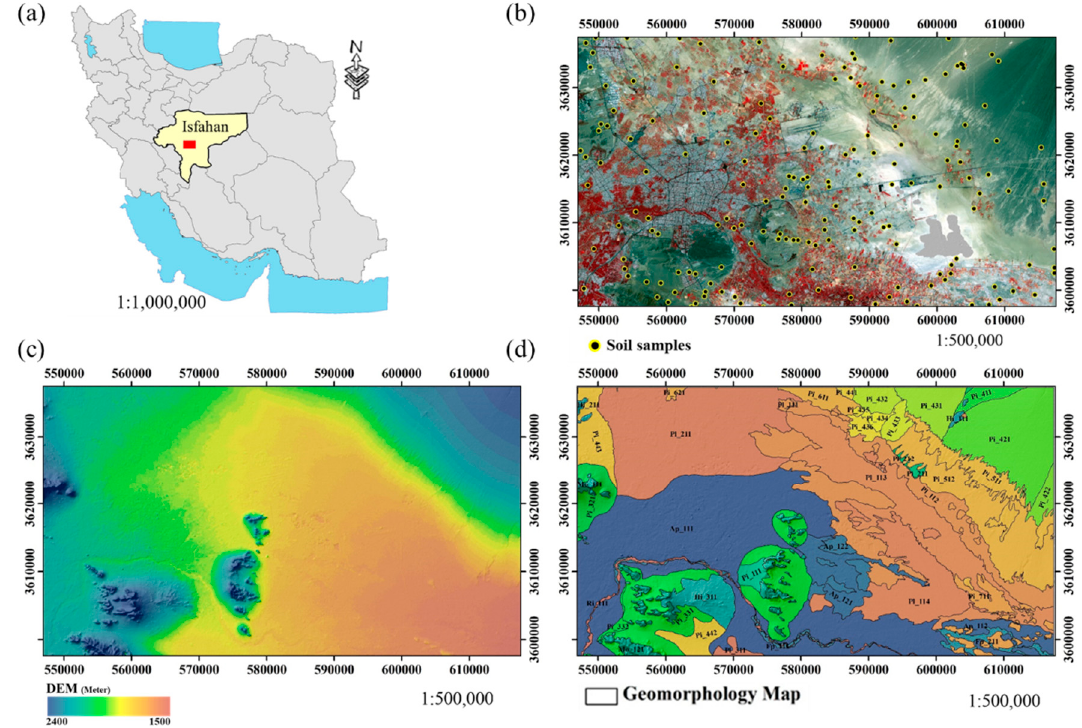
Figure 1. Location of study area in Iran ( a ); soil samples distribution ( b ); a digital elevation model ( c ) and geomorphology map of the region ( d ). Codes of geomorphology map refer to supplementary A.